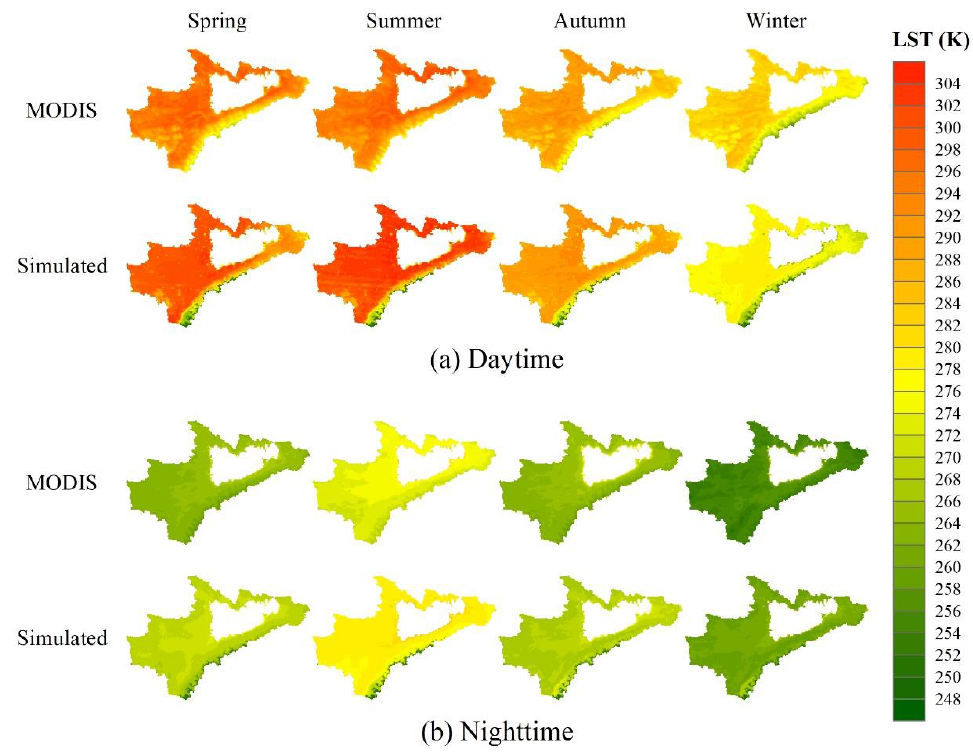
Figure 6. Comparison of the simulated and MODIS-derived spatial patterns of seasonal mean daytime ( a ) and night-time ( b ) land surface temperatures during 2001–2016. Spring (MAM), summer (JJA) autumn (SON)and winter (DJF) were listed from left to right.